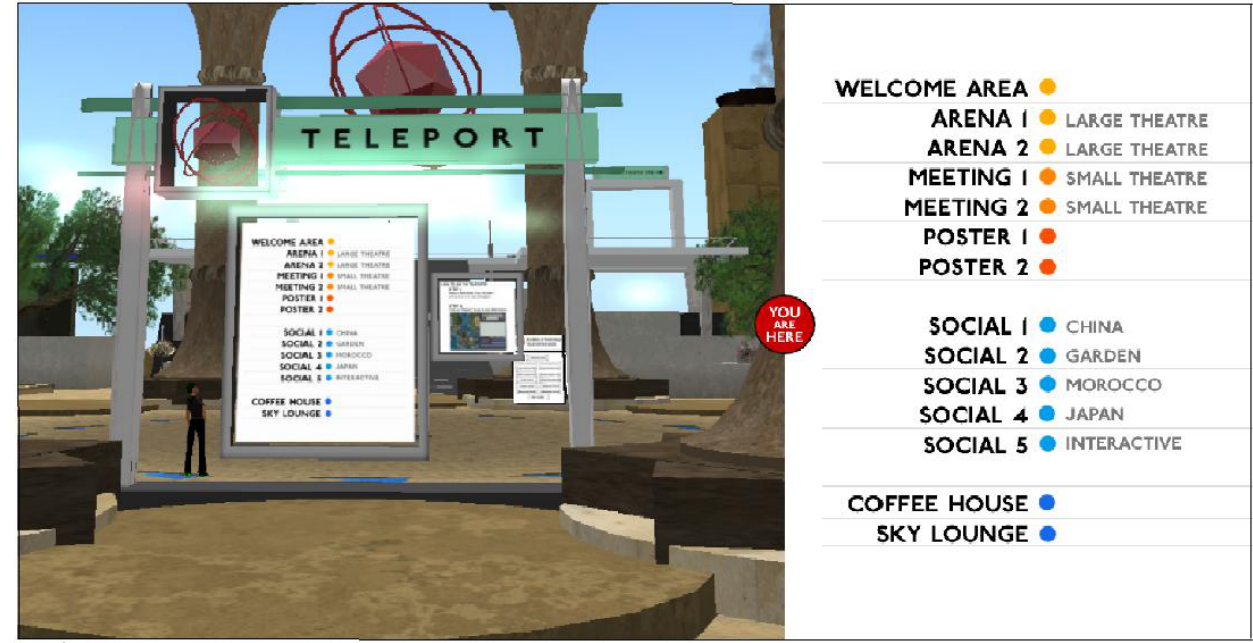
Figure 6. AGM 2009 Teleport Hub and Consistent, Color-coded